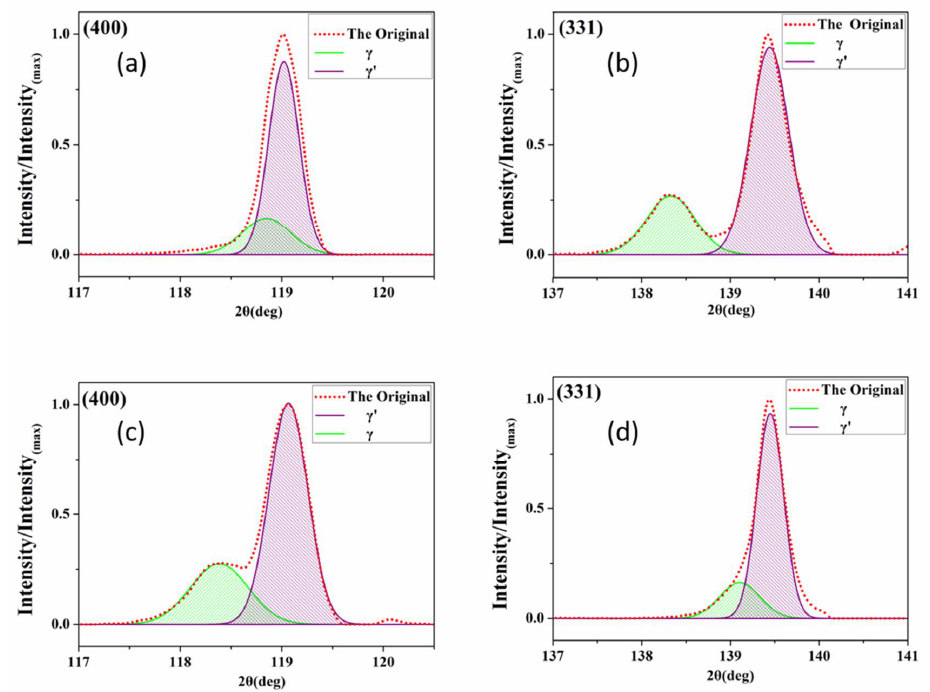
Figure 4. The diagram of a typical doublet fitting of the (400) ( a ) and (331) ( b ) reflections for the WC-C samples and the (400) ( c ) and (331) ( d ) reflections for the FC-C samples, where the γ and γ ′ structures and their subprofiles are marked to illustrate the reciprocal relationship between them.